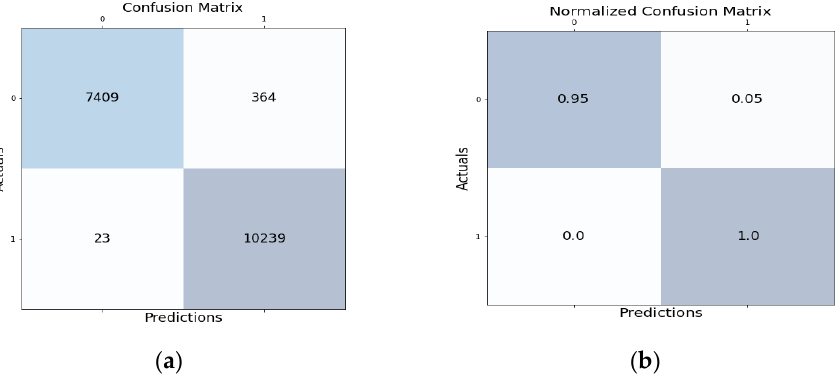
Figure 3. ( a ) Confusion matrix and ( b ) normalized confusion matrix for proposed HNIDS model for BCC